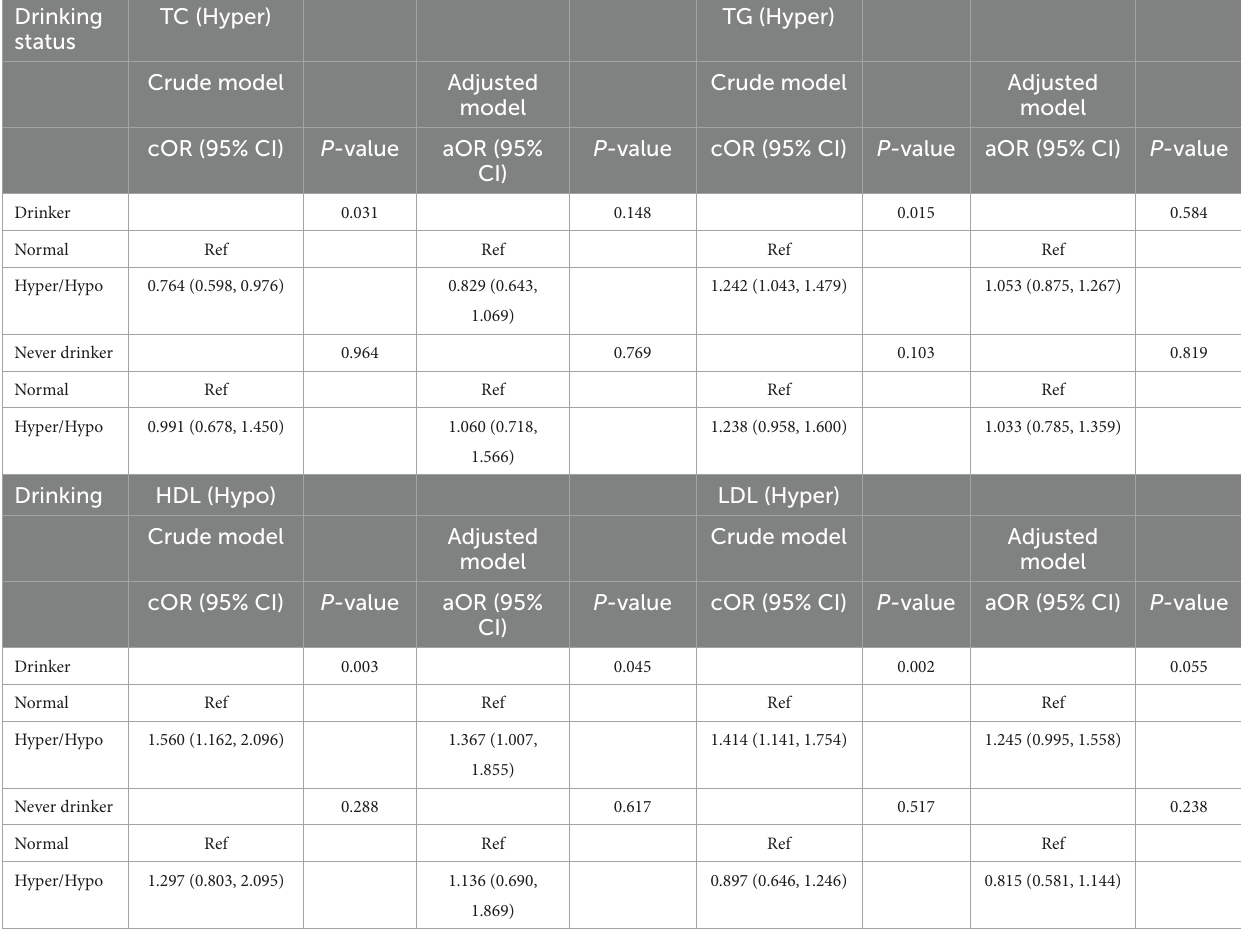
TABLE 8 Odds ratios for associations between triglyceride and cholesterol levels and anti-HBs results stratified by drinking status. Drinking